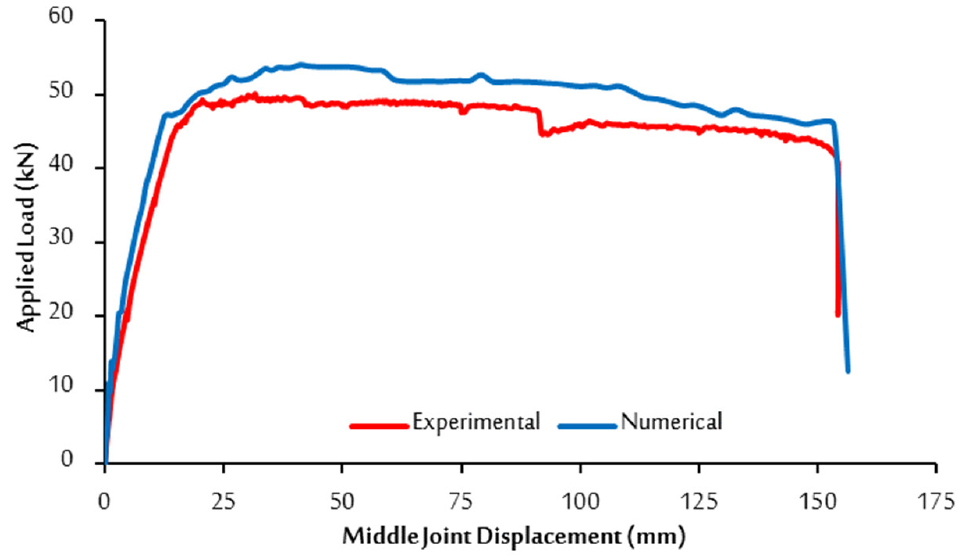
Figure 12. Comparison of the experimental and numerical load–displacement response of the RuC frame.